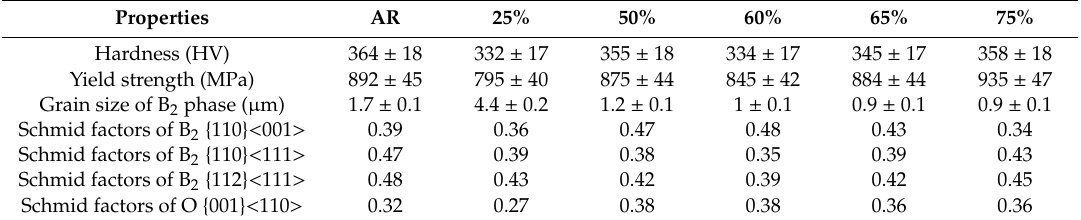
Figure 15. Hardness and mechanical properties of the as-rolled and can-compressed Ti 2 AlNb samples subject to annealing treatment (the micro-indentation was conducted on a surface perpendicular to the ND): ( a ) experimental procedure, ( b ) hardness, ( c ) yield strength, ( d ) grain size of B 2 phase and Schmid factors of the B 2 phase {110} < 001 > , {110} < 111 > , and {112} < 111 > slip systems, and the Schmid factors of the O phase {001} < 110 > slip system. Table 3. Hardness, yield strength, grain size of the B 2 phase, and the Schmid factors of the B 2 phase and O phase. AR—as rolled.